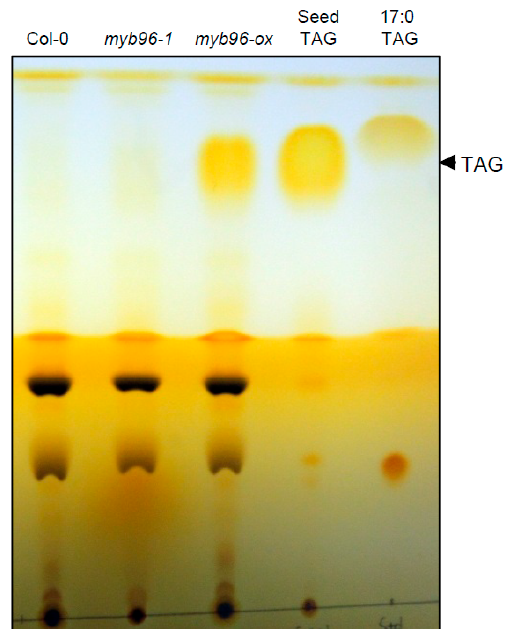
Figure 1. TAG accumulation in myb96-ox seedling. Ten-day-old seedlings grown under long-day (LD) conditions were used to extract total lipids. Extracted lipids were separated in thin layer chromatography (TLC) plates. Three independent biological replicates were analyzed, and the representative image is shown. TAG from wild-type seeds and 17:0 TAG standard were loaded on the right of the plate to indicate positions of the lipids.